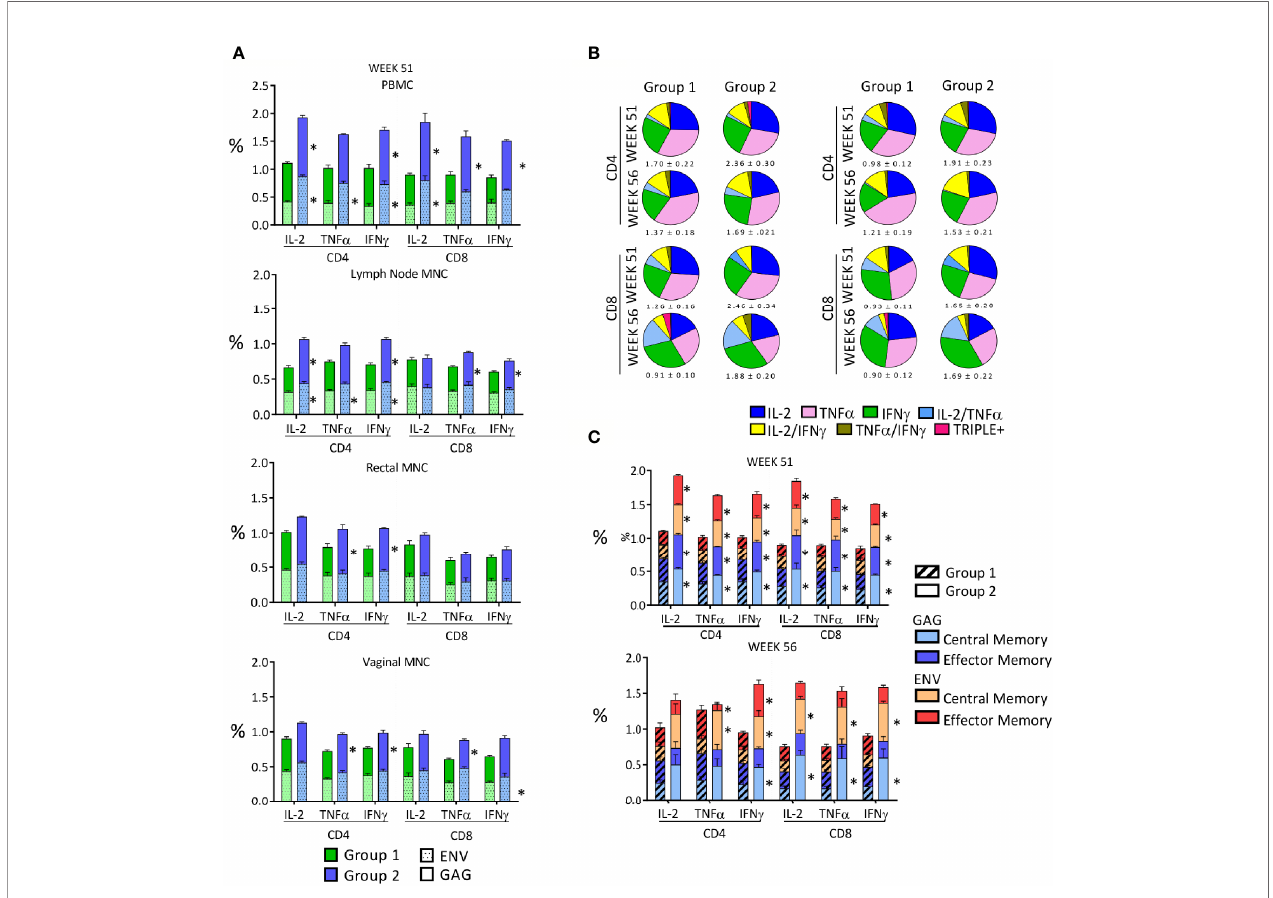
FIGURE 4 | Qualitative analysis of the anti-SHIV cell-mediated responses stimulated by the vaccination. (A) Anti - SIV Gag and Env percentages observed 2 weeks after the last immunization in the two vaccinated groups in PBMC, LN, rectal and vaginal MNC. Asterisks indicate signi fi cant difference between Group 1 and Group 2 and are placed adjacent to the relevant column segment. (B) Pie graphs representing the diversity of anti-SHIV CD4+ and CD8+ T-cell responses as relative fractions of the total percentages of positive cells, expressing a IFN g , TNF- a and IL-2 alone or a combination of them within anti-SIV gag (left panel) or anti-HIV env (right panel) responses. Functional analysis is in biopsies 2 weeks after the last immunization (week 51) and two weeks before challenge (week 56). The total mean percentage and SE of the antigen-speci fi c responses for each analyzed variable is shown below each pie. (C) Central memory (C M ) and effector memory (E M ) fractions in SHIV-speci fi c cell-mediated T-cell responses present in PBMC on week 51 (2 weeks after last immunization) and week 56 (naïve cells: CD28+CD95-; memory T cells: CD28+CD95+; and effector T cells: CD28-CD95+). The average percentages of anti-Gag and anti-Env T cells in each group are stacked in the column and shaded differently. Asterisks adjacent to column segments indicate a signi fi cant difference between Groups 1 and 2 for that segment. Between groups comparisons reported in panels (A, C) were carried out by two-tailed, t test or Mann-Whitney U test if the value distribution was non- parametric (p value range: